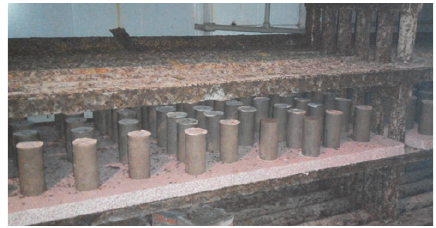
Figure 2: Mixture example with basalt fibre and